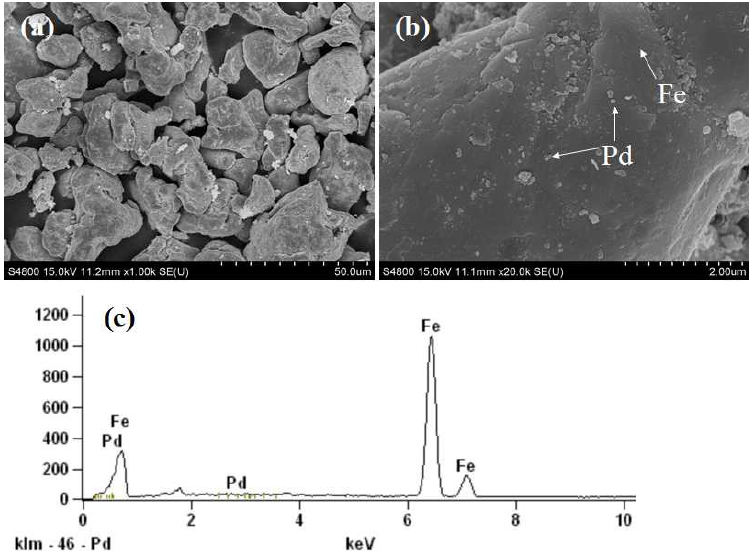
Figure 1. FESEM at different magnifications. ( a – c ) EDS of Pd/Fe (0.05% initial adding, w / w ) bimetallic particles.